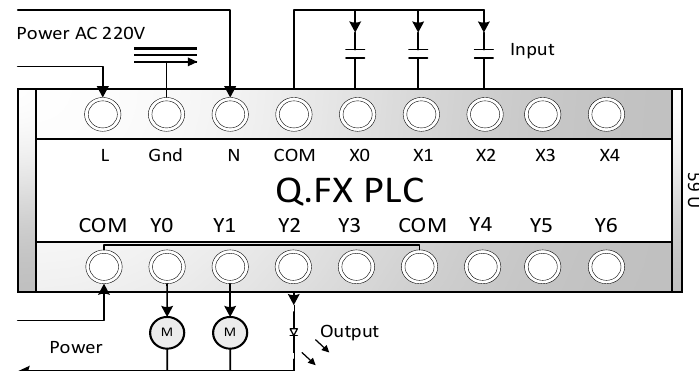
Figure 9. The PLC corresponds to the X~X4 contacts, where X is the input contact, Y is the output contact, M is the external motor, and COM is the common parallel point. The L and N of the power supply represent the live and neutral wires, respectively. The Q and FX models are PLCs introduced by the MITSUBISHI Company. This PLC, designed for this system, allows the control logic program to be updated through the users such as the DT mapping model in DT-HMIS of this system, without being limited by the developer. Users/patients can also extend peripheral device control on their own.